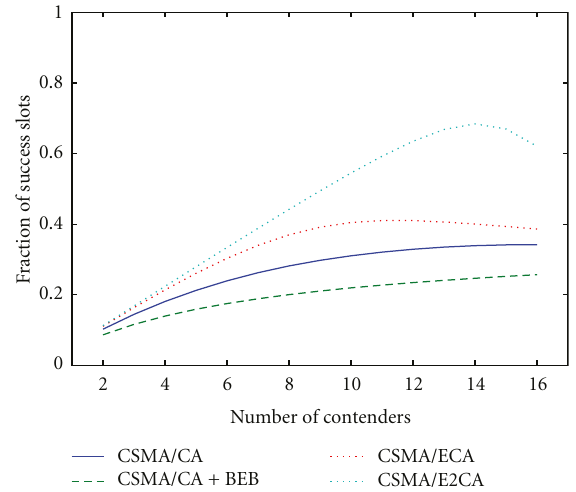
Figure 10: Fraction of success slots for each of the three protocols under comparison for di ff erent number of contenders in a channel that drops 10% of